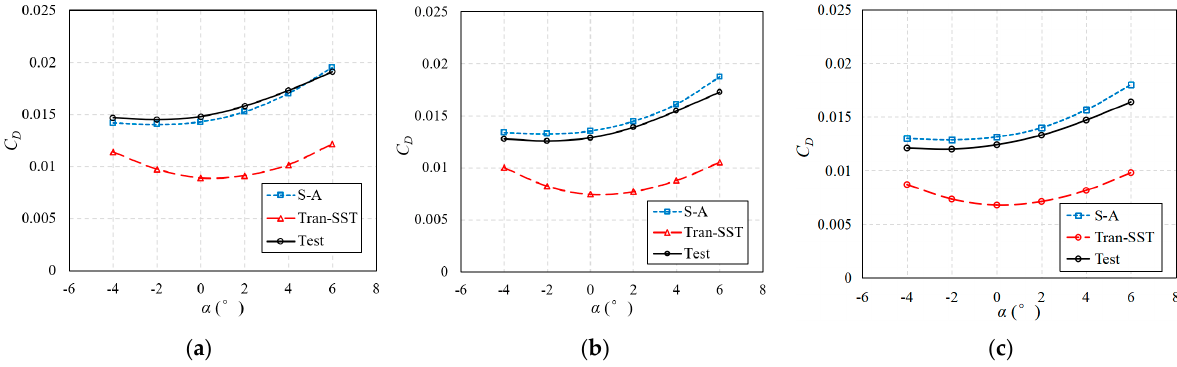
Figure 18. Comparison of drag coefficient curves obtained by different methods: ( a ) v = 6.4 m/s; ( b ) v = 9.0 m/s; ( c ) v = 11.0 m/s.